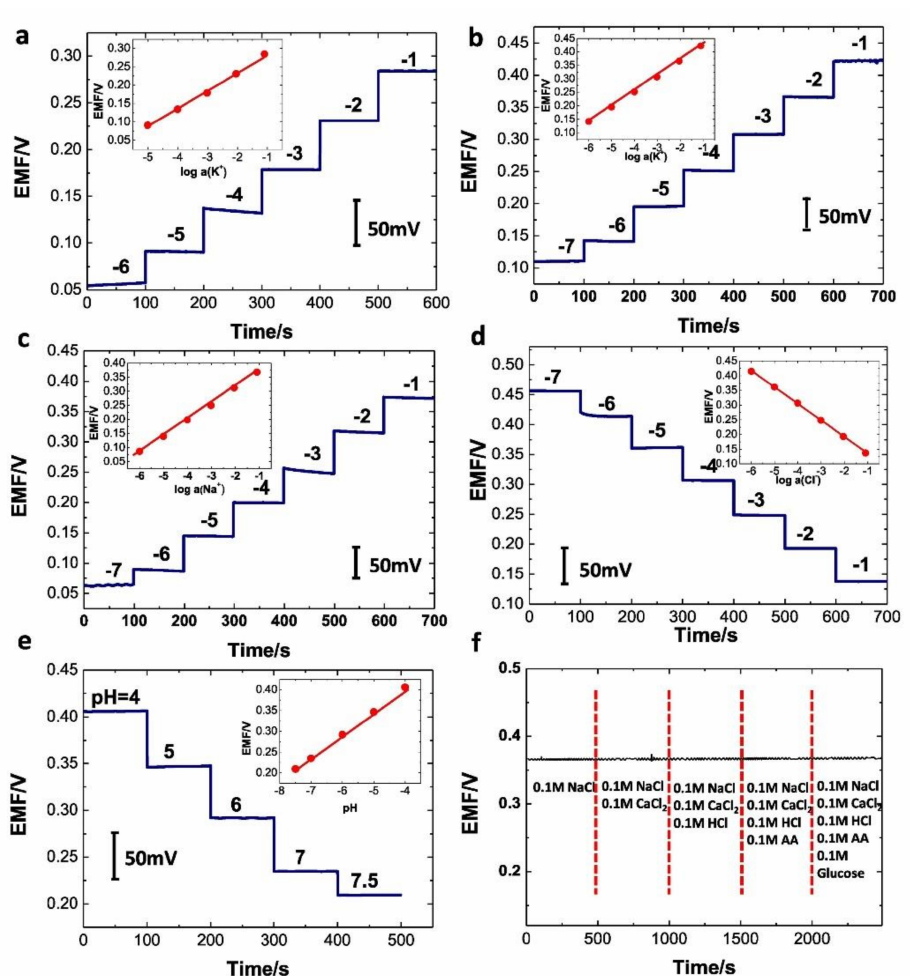
Figure 33. ( a – e ) The K + -GCE, K + -GPE, Na + -GPE, Cl − GPE, and H + -GPE calibration curves and open-circuit potential responses. ( f ) Interference testing for Na + -GPE. (Reproduced from [577] with permission. Copyright 2019, Elsevier, Amsterdam, The